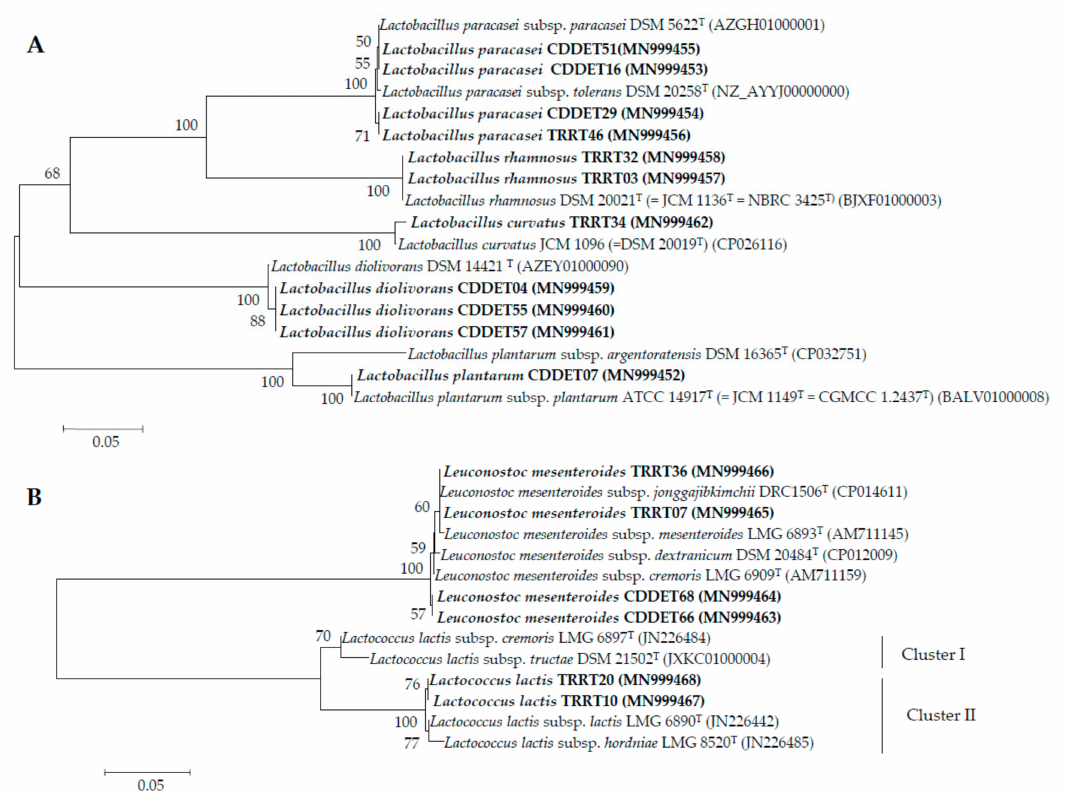
Figure 2. ( A ) Neighbour-joining phylogenetic unrooted tree based on pheS gene partial sequences (400 nt) showing the taxonomic location of representative strains from di ff erent groups of MALDI-TOF MS within the genus Lactobacillus . ( B ) Neighbour-joining phylogenetic unrooted tree based on pheS gene partial sequences (400 nt) showing the taxonomic location of representative strains from di ff erent groups of MALDI-TOF MS within the genera Lactobacillus and Leuconostoc . Bootstrap values calculated for 1000 replications are indicated. Bar, 5 nt substitution per 1000 nt. Accession numbers from Genbank are given in